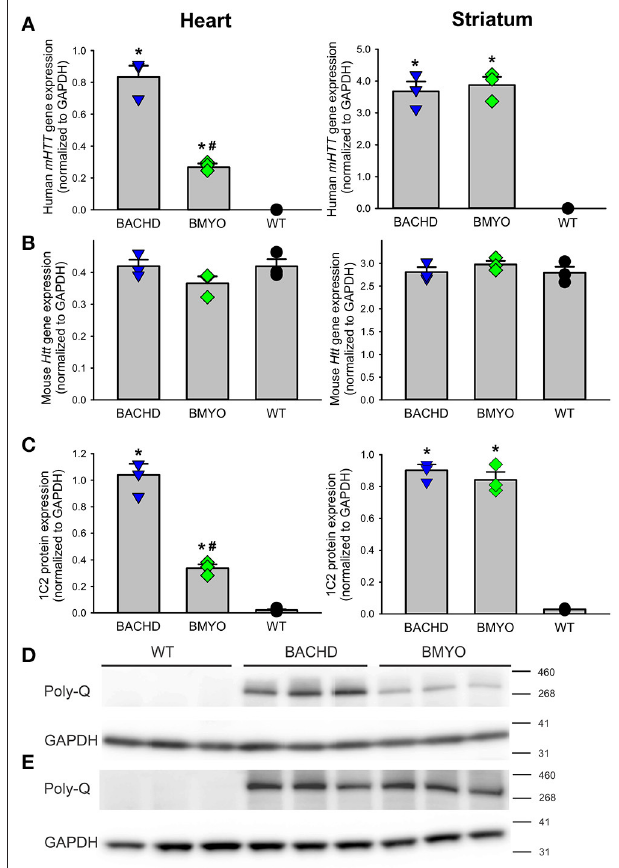
FIGURE 2 | Genetic targeting of human mHTT elicits a selective reduction of its transcript and protein expression levels in the heart, but not the striatum of 3 months old BMYO mice. (A) Quantification of the human mHTT transcript levels in the heart and striatum shows a significant and selective decrease in the heart of the BMYO line [ F (2,8) = 125.5, P < 0.001]; while, striatal levels were comparable in the two mutant lines [ F (2,8) = 87.706, P < 0.001]. (B) The levels of the endogenous mouse Htt were unchanged among genotypes in both the heart [ F (2,8) = 2.045, P = 0.210] and striatum [ F (2,8) = 0.852, P = 0.473]. (C) PolyQ protein expression levels were detected in the BACHD heart and were greatly reduced in the BMYO [ F (2,8) = 162.549, P < 0.001], but not in the striatum of both mutants. These data demonstrate that the genetic cross was successful, and the mHTT levels were selectively reduced in the BMYO heart, while maintaining “normal” expression in the striatum. Representative immunoblots for the heart (D) and (E) striatum. Values derived from the densitometric analysis were corrected for the background and normalized to GAPDH. The vertical bar plots represent the group means and SEM. The symbols show the values for each individual animal (n = 3) per genotype. Asterisks represent significant differences ( P < 0.05) compared to WT while crosshatch indicates significant differences ( P < 0.05) between BMYO and BACHD. One way ANOVA followed by Tukey’s